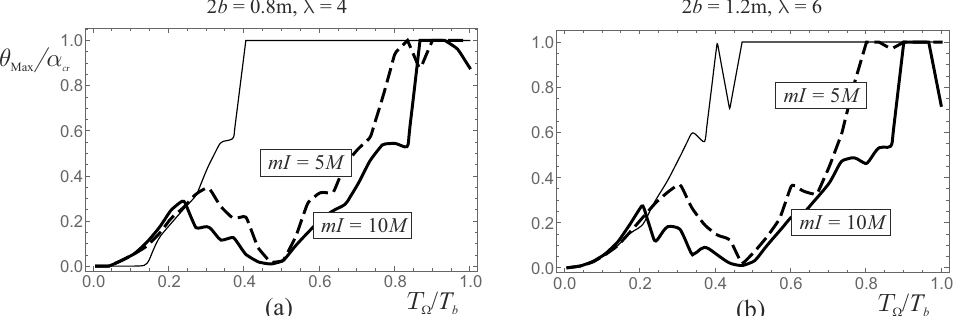
Figure 5. Frequency–response curves of coupled systems (thick solid and dashed lines) and corresponding stand-alone rigid blocks (thin lines): ( a ) curves for different apparent masses m I ( T aux = 0.25 T b , u y = 1/3 u cr , m = 0.05 M , ψ = 0.2); ( b ) curves for different yielding displace- ments u y ( T aux = 0.5 T b , m I = 5 M , m = 0.05 M , ψ = 0.2); ( c ) curves for different physical masses m ( T aux = 0.5 T b , m I = 5 M , u y = 1/3 u cr , ψ = 0.2). Dimensions of the rigid block: 2 b = 0.6 m and λ = 5 ( r = 0.9423).